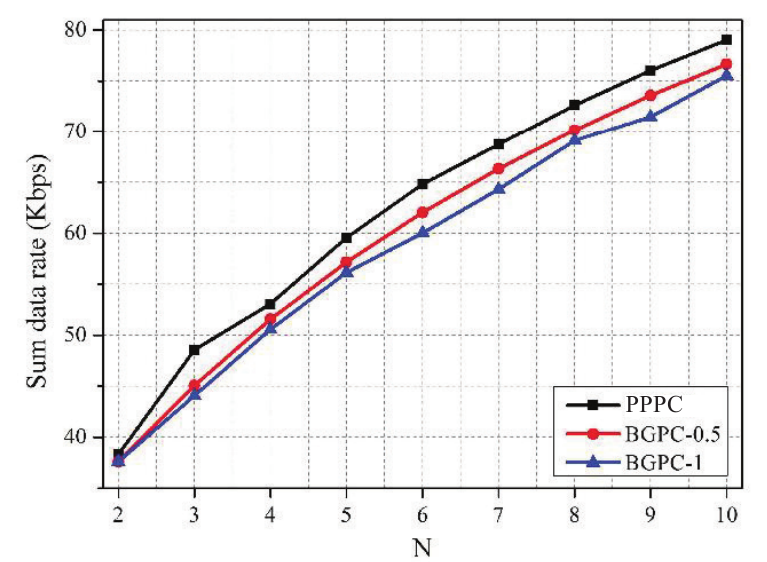
Figure 11. Sum data rate vs. N under schemes with different pricing